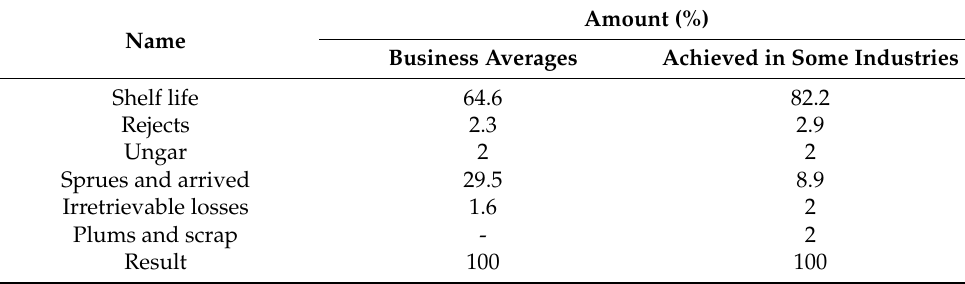
Table 1. Balance of induction furnace metal in Russia.